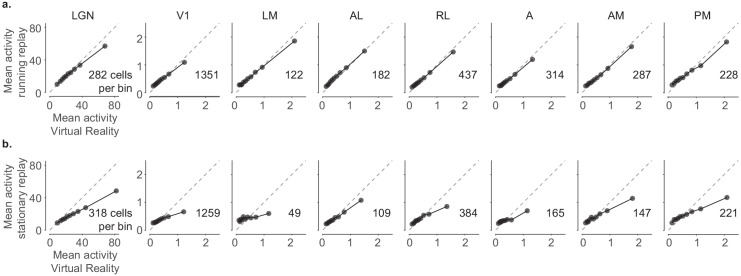
Comparison of neuronal activity in virtual reality (VR) and replay conditions.(a) Comparison of the mean activity between VR and running replay for all probed visual areas, split into 10 percentile bins. (b) Same as in (a) for stationary replay. Mean activity was similar between VR and running replay but decreased significantly during stationary replay in many areas (paired-sample right-tailed t-test: running replay: lateral geniculate nucleus (LGN): p=0.003; p>0.05 in all cortical areas; stationary replay: LGN: 10−65, V1: 10−24, LM: 0.93, AL: 0.15, RL: 0.06, A: 0.56, AM: 0.03, PM: 10−09).